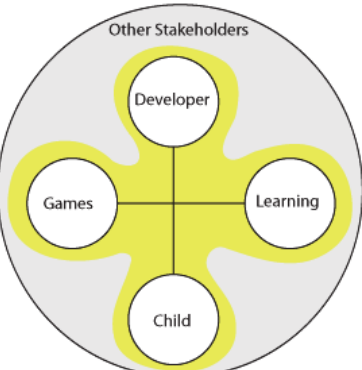
Figure 7. The five dimensions within serious